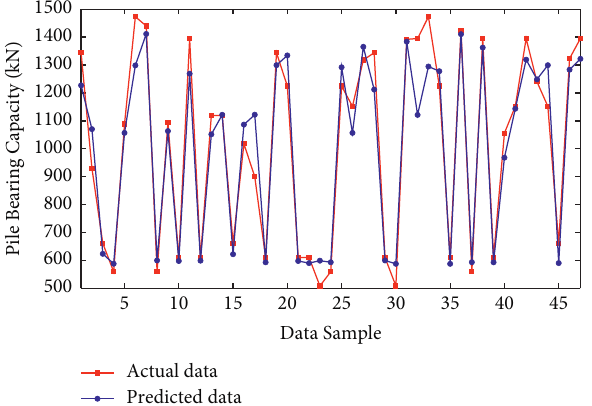
Figure 9: Actual vs. predicted response variables. Residual Distribution: Mean = 0.000, Std. Dev. = 77.194